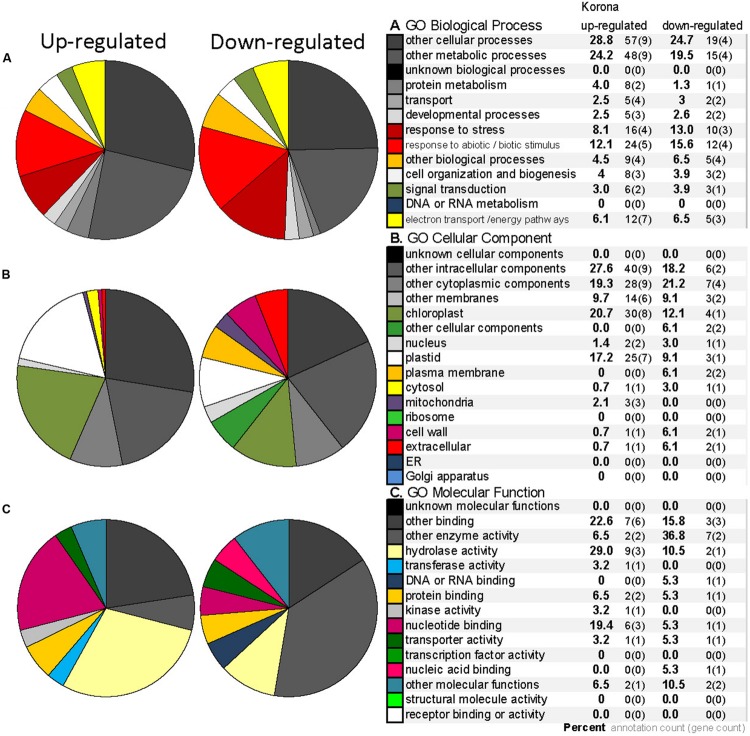
Gene Ontology (GO) annotation for the differentially expressed proteins from 2DE analysis (homologous to Arabidopsis genes) in F. ananassa ‘Korona.’ GO categories for Biological Process (A), Cellular Component (B), and Molecular Function (C) for the differentially expressed proteins that were up-regulated (10 spots) or down-regulated (11 spots) greater than 1.5 fold after treatment at 2°C at either 24 or 240 h (listed in Table 1). Legend includes the percent (bold) next to number of annotations and number genes included within each category.